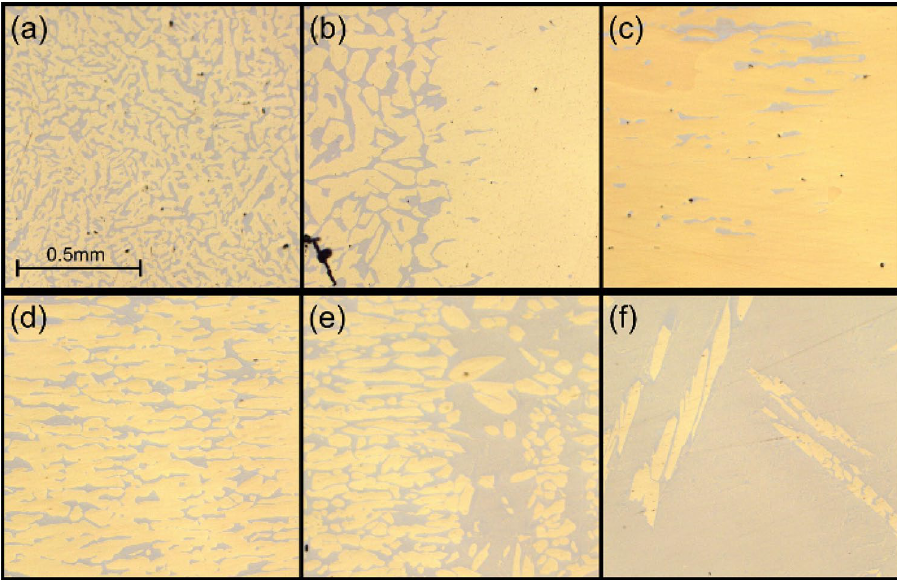
Figure 1. Optical micrographs taken along the resolidified Cu 86 Ga 5 Sn 9 sample at positions with increasing temperature: ( a ) as-cast, ( b ) microstructural transition initial solidus temperature, ( c ) mostly α-phase and a small fraction of δ, ( d ) increasing fraction of δ, ( e ) high δ fraction and ( f ) α in